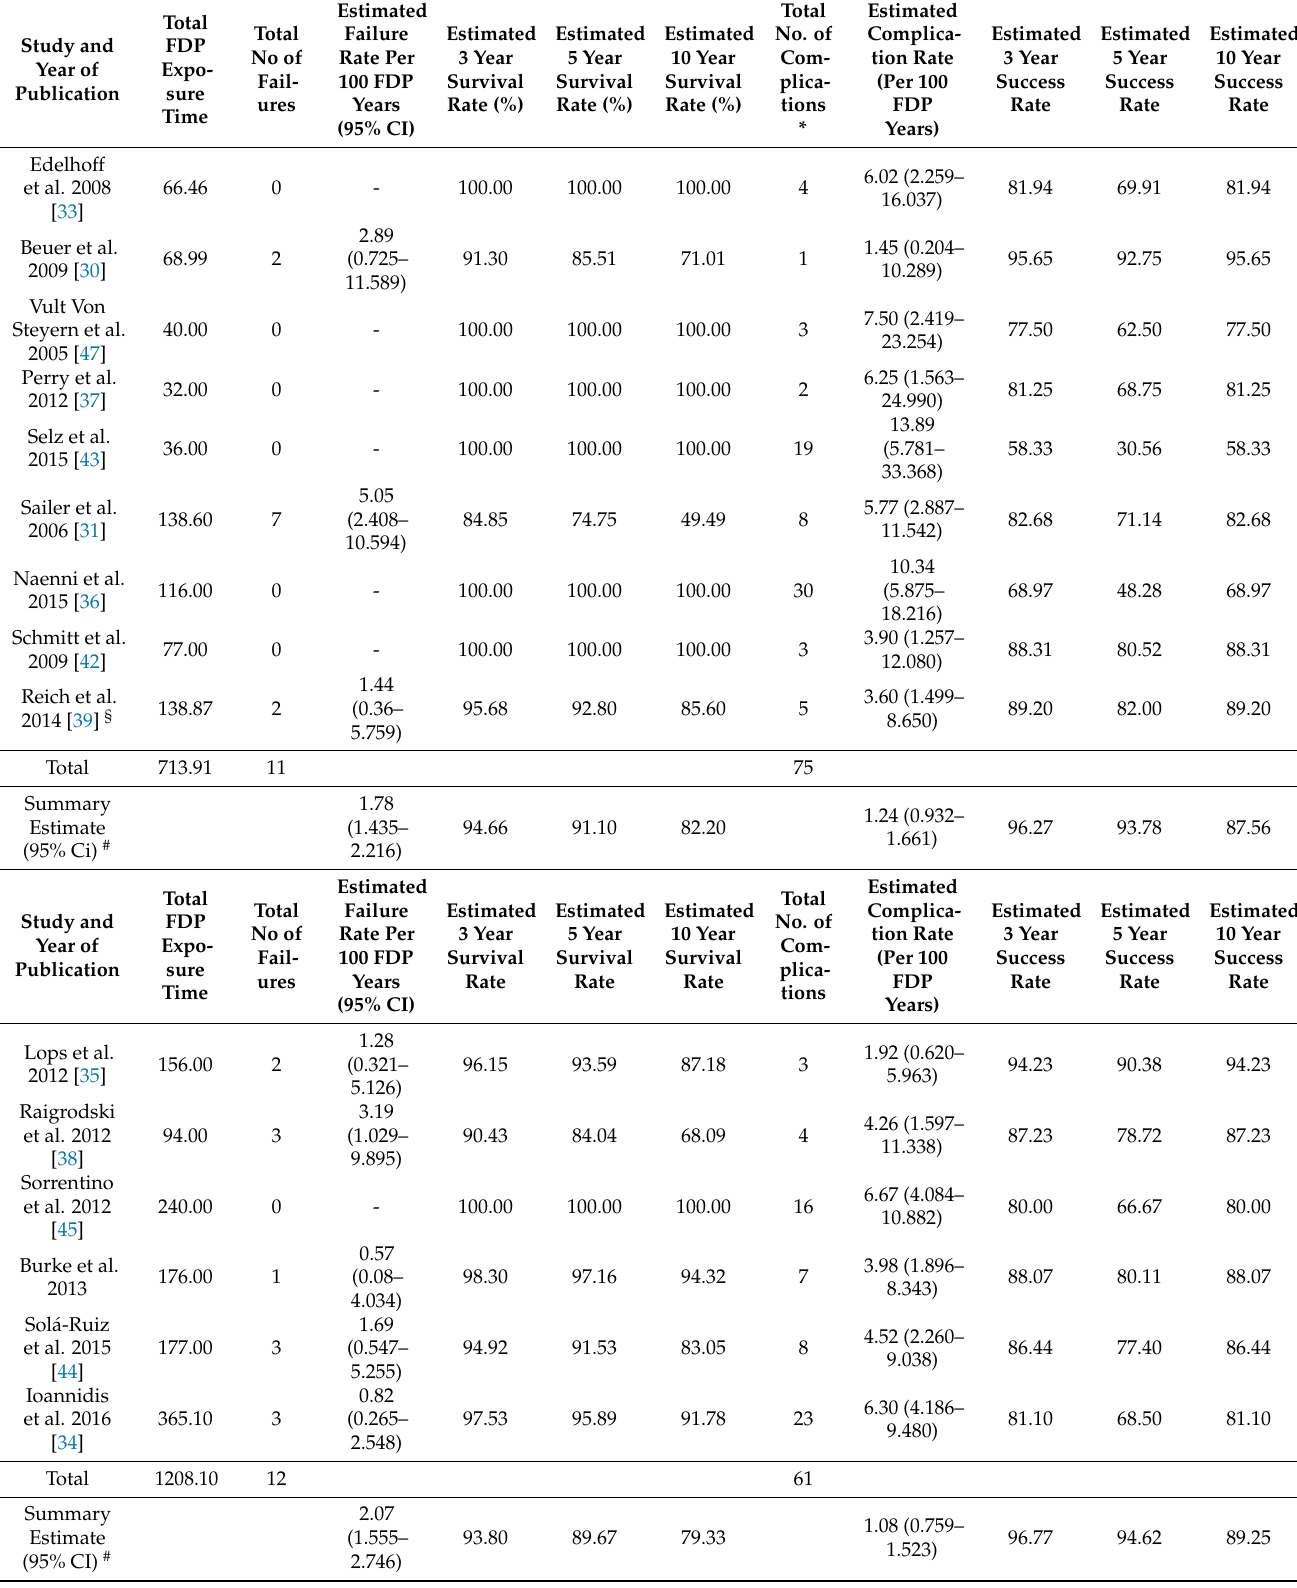
Table 3. Illustration of estimated failure rates, complication rates, and survival rates stratified by follow-up time